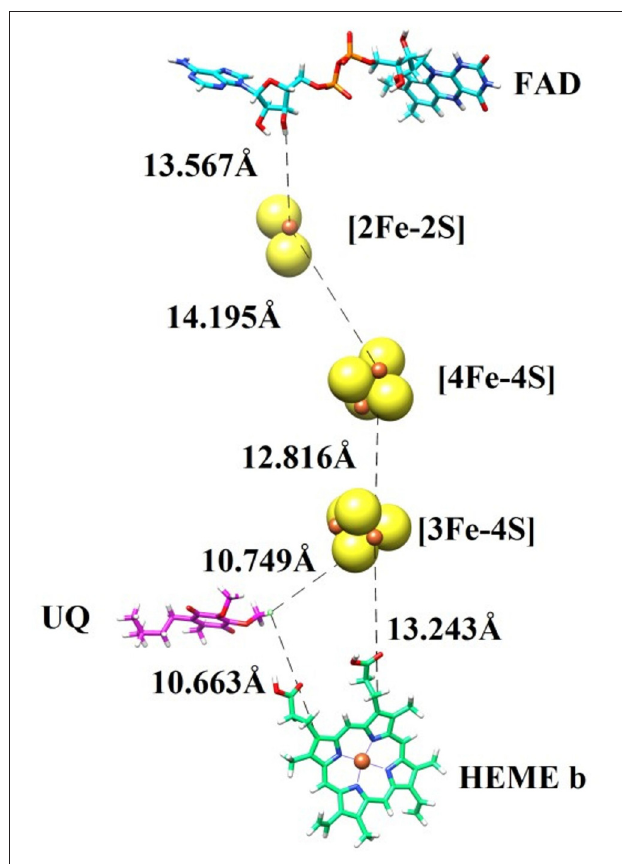
FIGURE 2 | The prosthetic groups constituting the electron transfer pathway (FAD, [2Fe-2S], [4Fe-4S], [3Fe-4S], and heme b) are shown together with ubiquinone (UQ), along with their edge-to-edge